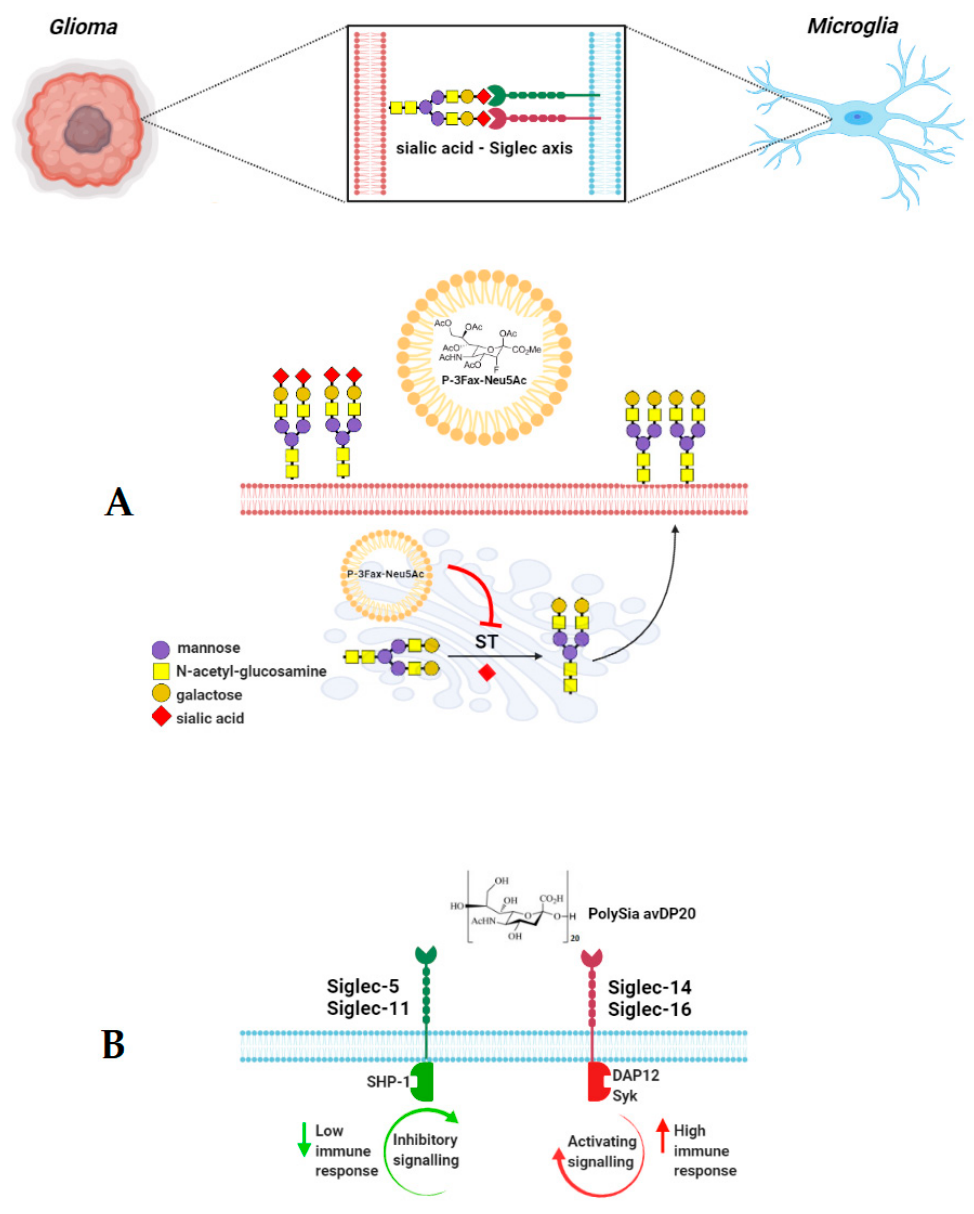
Figure 2. Possible strategies of targeting Siglecs and membrane sialome in glioma management. The administration of fluorinated sialic acid derivatives modulates the expression and activity of sialyltransferases (ST) in Golgi and results in the desialylation of the cell surface ( A ). Depending on inhibitory or activatory Siglec expression patterns, the binding of specific sialic acid polymers modulates the antitumor immune response ( B ). DAP12—AX activation protein of 12kDa; Syk—spleen tyrosine kinase; SHP-1—Src homology region 2 domain-containing phosphatase-1; SHP-2—Src homology region 2 domain-containing